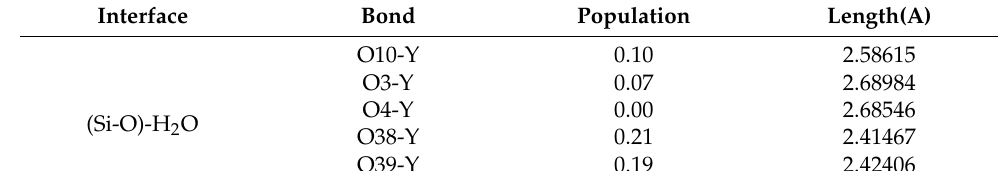
Table 4. Distribution of the Mulliken bonds of Y(III) on the (Si-O)-H 2 O interface. Table 4 show that after the adsorption reaction, Y(III) bonds with the three O atoms Interface Bond Population Length(A) on the (Al-OH) surface of kaolinite and the oxygen atoms in the three water molecules. O10-Y 0.10 2.58615 The bond populations of Y-O10, Y-O3 and Y-O4 are 0.1,0.07 and 0.00, respectively, and O3-Y 0.07 2.68984 the bond lengths are 2.58615 Å, 2.68984 Å and 2.68546 Å. Y bonds with H 2 O(38), H 2 O(39), O4-Y 0.00 2.68546 (Si-O)-H 2 O O38-Y 0.21 2.41467 and H 2 O(52). The bond populations are 0.21, 0.19, and 0.18, respectively, and the bond O39-Y 0.19 2.42406 lengths are 2.41467 Å, 2.42406 Å, 2.61860 Å. O52-Y 0.18 2.61860